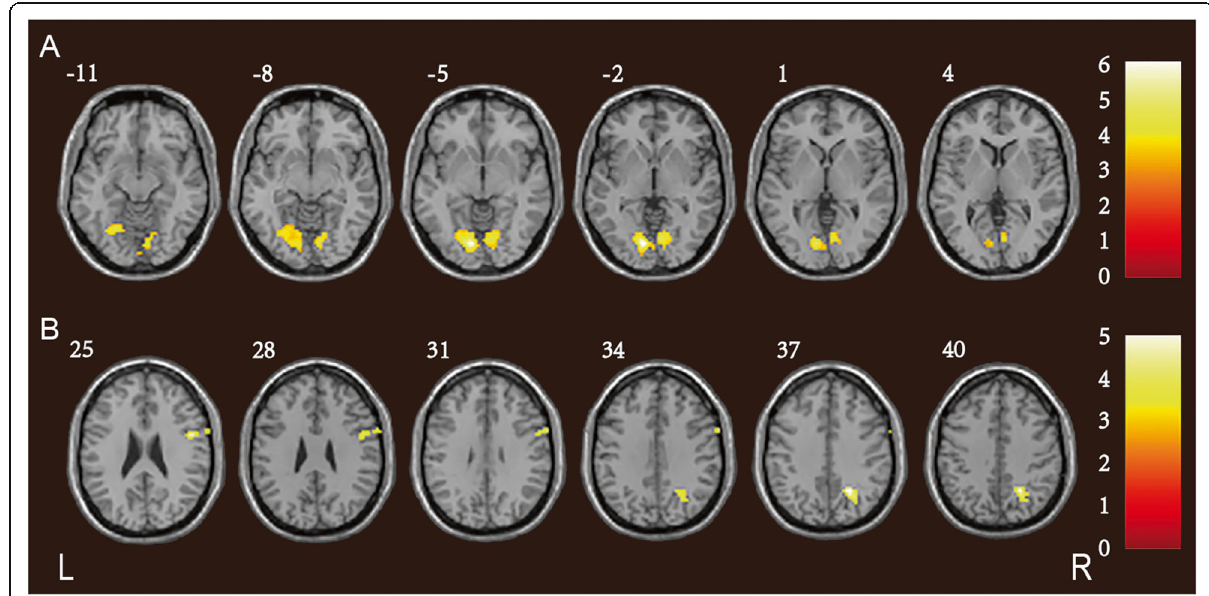
Fig. 1 Reduced intra-network connectivity in patients with CADASIL. The CADASIL group exhibited decreased activity of the bilateral LG and the right CU within the VIN ( a ); and of the right Pcu, IFG, and precentral gyrus within the FRN ( b ), compared to the control group. The t- values are color-coded. CADASIL: cerebral autosomal dominant arteriopathy with subcortical infarcts and leukoencephalopathy; LG: lingual gyrus; CU: